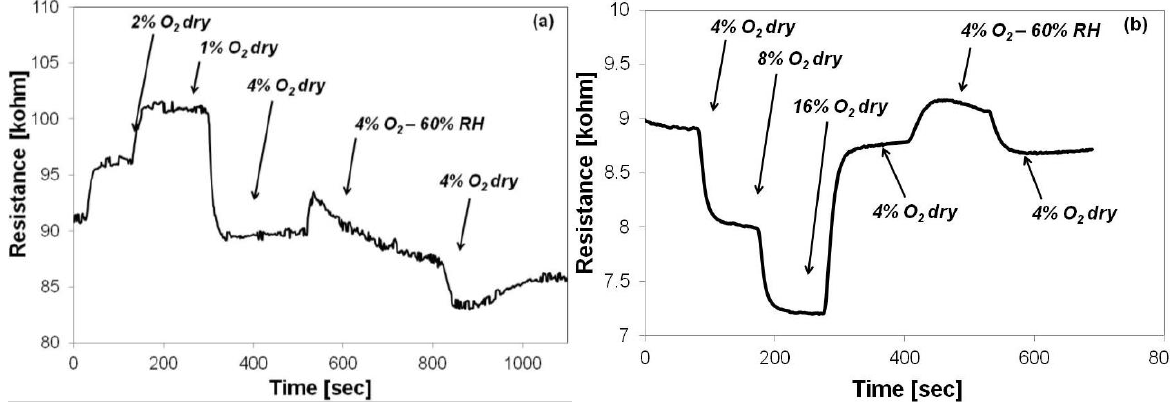
Figure 8. Sensor response in dry (RH = 0%) and humid nitrogen environment (RH =